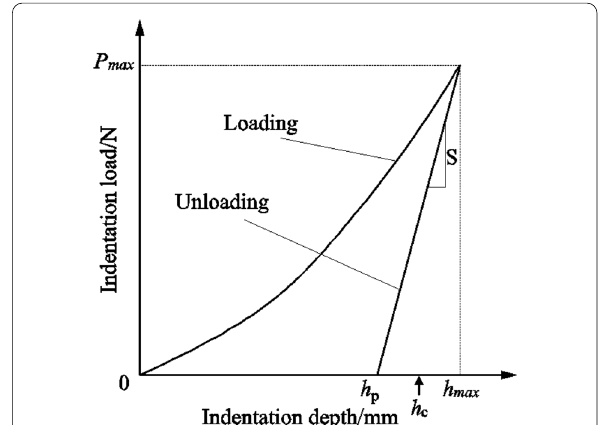
Figure 1 The typical load-depth curve